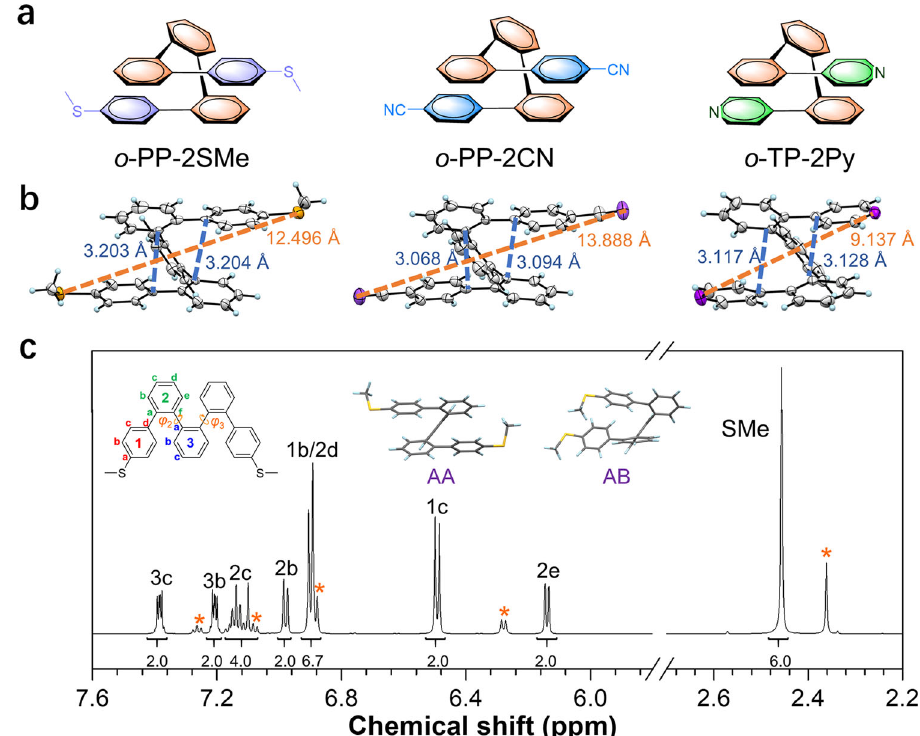
Fig. 2 General structural characterization for o -PP derivatives. a Chemical structures for o -PP-2SMe, o -PP-2CN, and o -TP-2Py, respectively. b Single crystals for o -PP-2SMe, o -PP-2CN, and o -TP-2Py, respectively. The orange dashed lines refer to the distances between sulfur atoms with exact values in orange. The blue dashed lines refer to the closest interplane distances between two biaryl groups with exact values in blue. c 1 H NMR spectrum at − 5 °C of o -PP-2SMe in AA conformer (500 MHz, CD fi c protons of o -PP-2SMe in AA conformer. Asterisks: the minor 2 Cl 2 ) with major peaks assigned to speci signals from AB conformer. The insets include the schematic structure of o -PP-2SMe with certain letters referring to speci fi c protons and numbers referring to the aryl rings, and two distinguishable conformers in the NMR analysis, the AA conformer corresponding to the major signals and the AB conformer corresponding to the minor signals. The two internal dihedral angles φ 2 and φ 3 are also labeled in the